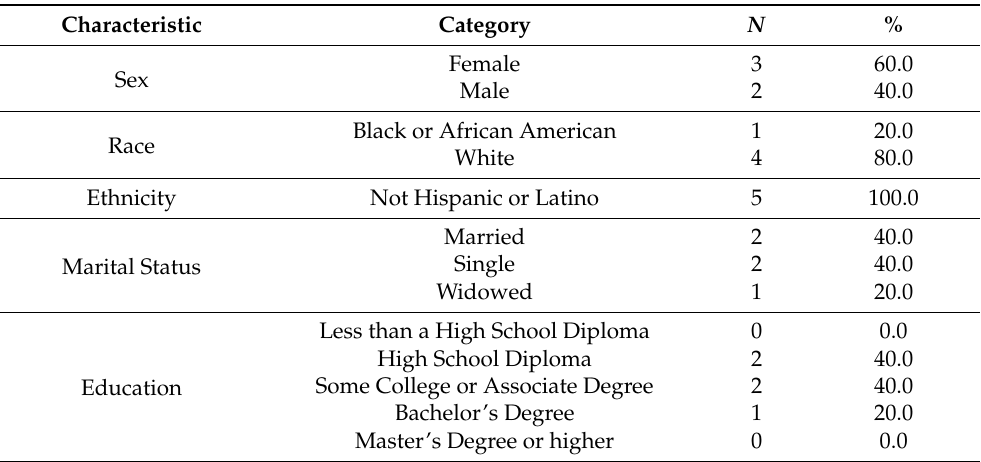
Table 2. Participant background characteristics ( N = 5).